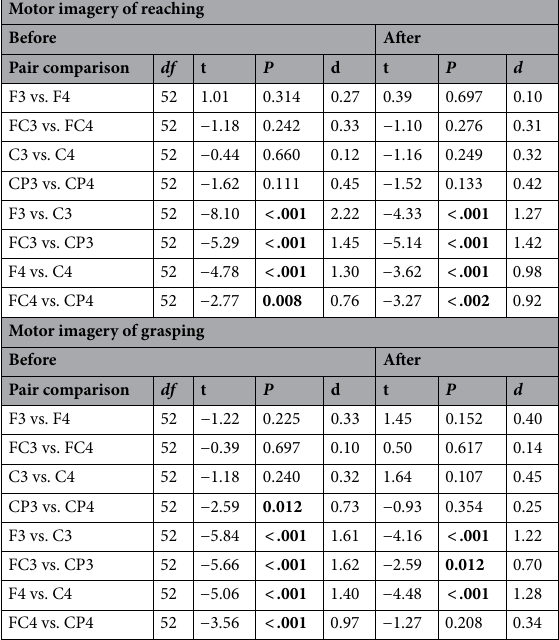
Table 3. Results of pairwise comparison for ERP amplitude between electrodes located above the right compared to the left hemisphere, and between electrodes located above the premotor cortex compared to the sensorimotor cortex of the same hemisphere for MIR and MIG before and after MIT assessed with independent t - test . Bold font indicates statistical significance. Significant are in bold.